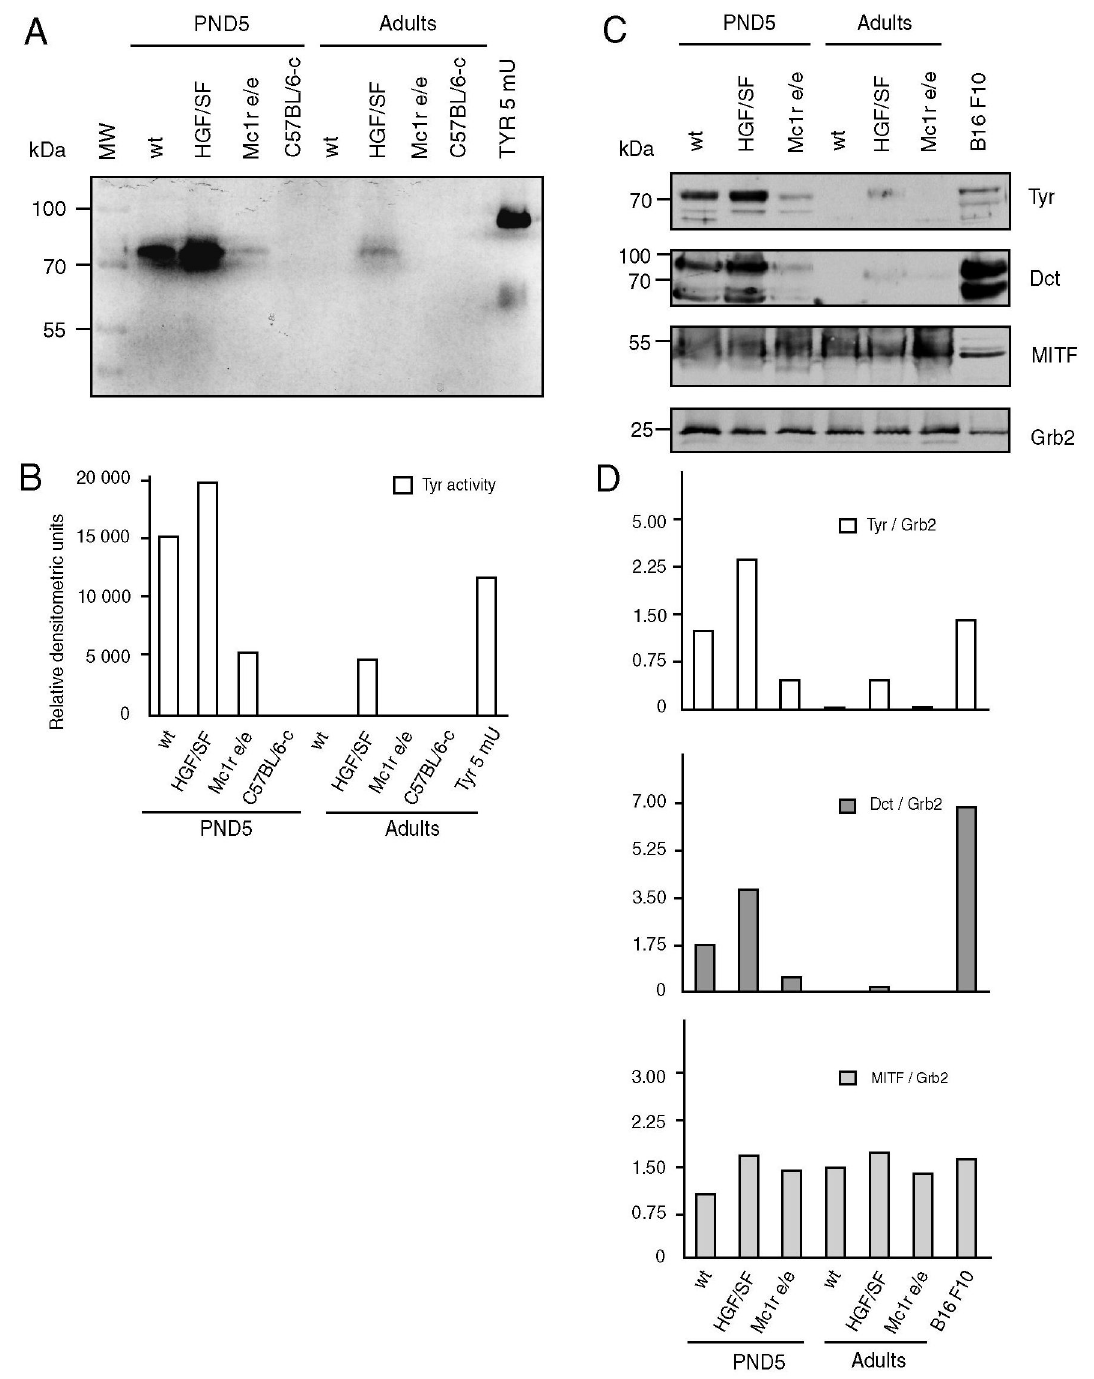
Figure 5. Tyrosine activity and expression of tyrosinase, Dct and MITF in PND5 and 3 weeks (adult) C57BL/6 mouse skin. (A) Zymography of tyrosinase activity. (B) Densimetric analysis of the zymogram, positive control-purified tyrosinase from Agaricus bisposrus , 5 mU (TYR 5 mU), negative control C57BL/6- c . (C) Immunoblotting. (D) Densitometric analysis of the bands – Tyrosinase (Tyr), DOPAchrome tautomerase (Dct) and MITF expression was normalized to a reference protein Grb-2, that served as a loading control. The Western blot experiments were performed on two different set of the samples, each set repeated twice. The figure shows the representative results.